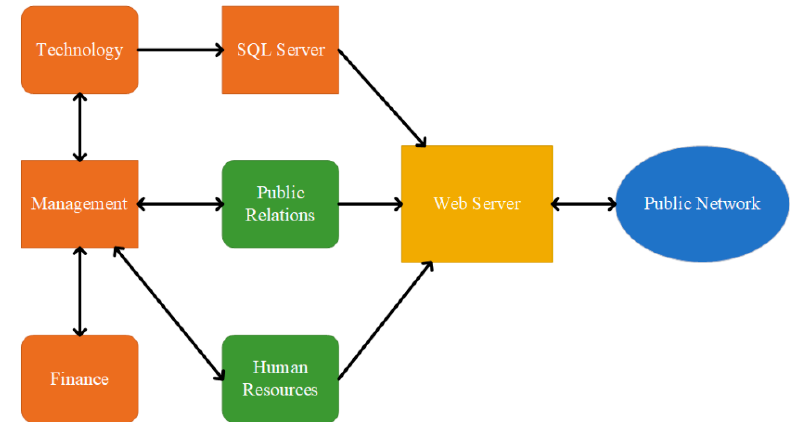
Figure 5. Relationships of units.